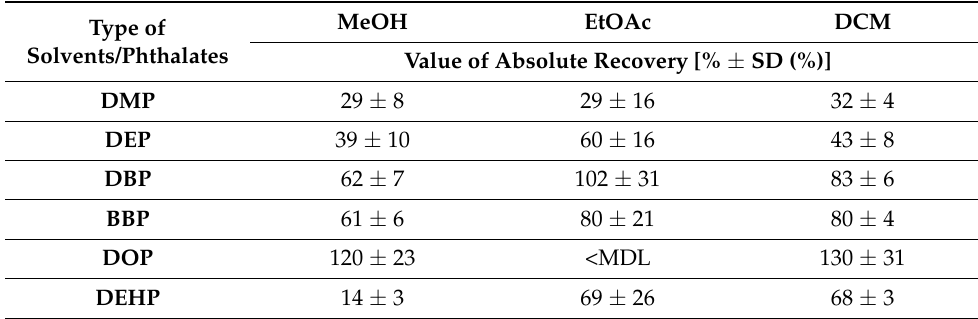
Table 2. Absolute recoveries (mean ± SD) of six analytes using different solvents during the UAE procedure (n = 3, conc. 1000 ng × g − 1